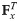
An illustration of the decompose-and-split operation.In this example, partial likelihood FxT is decomposed into six vectors F0 to F5. An illustration of how F4 is split in the four possible ways to trace branches y and z is shown, and every split is assigned a unique label.